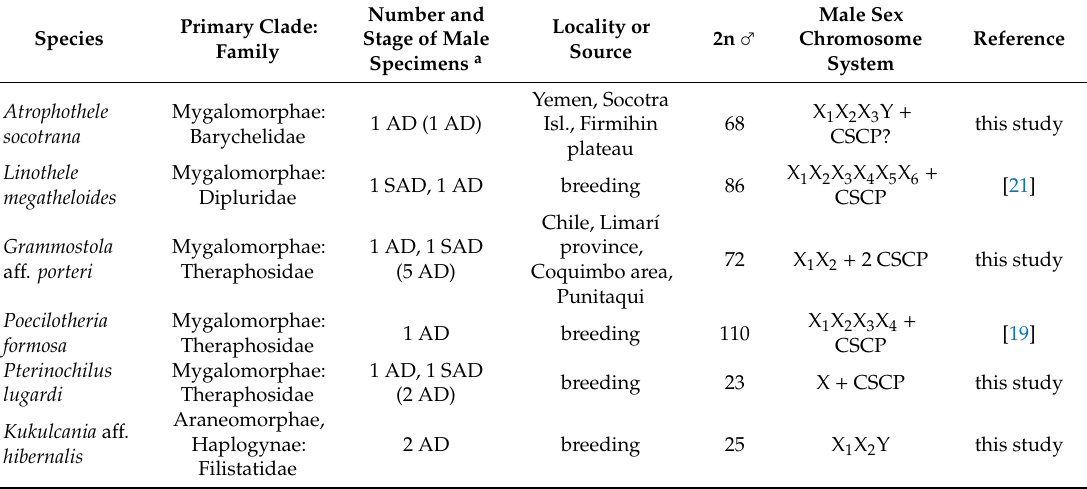
Table 1. List of analysed spider